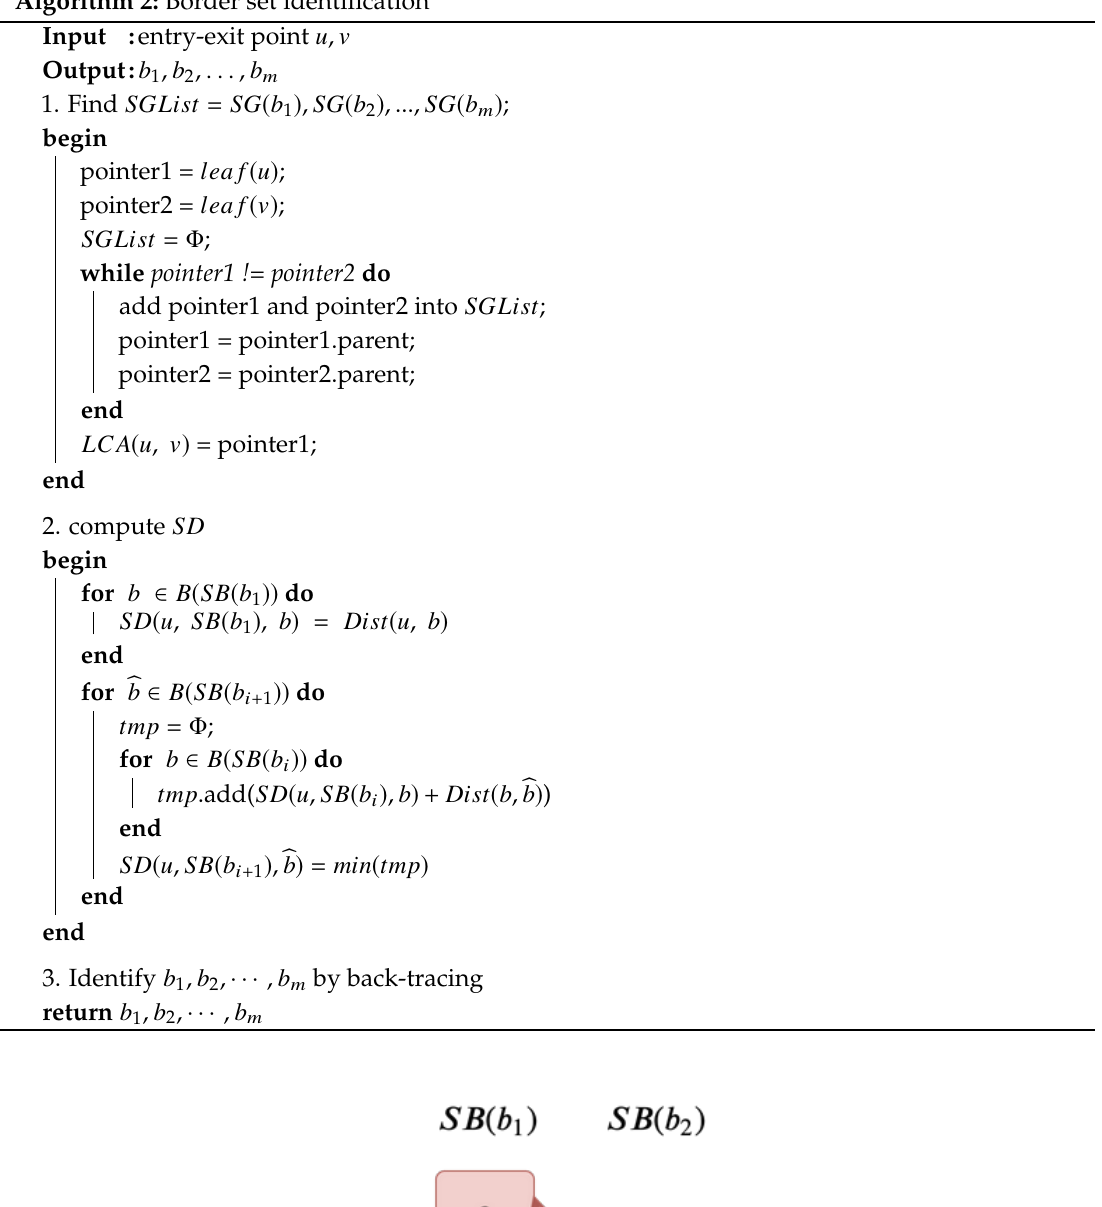
Algorithm 2: Border set identification